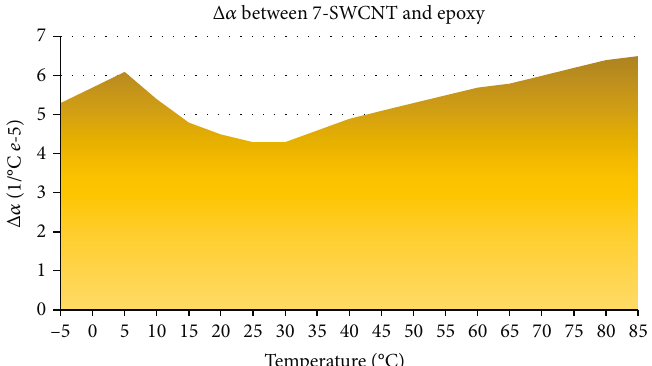
Figure 7: Mismatches between the CTEs of 7-SWCNT and epoxy ( Δα ) at the temperature range of -5 to 85 ° C within the